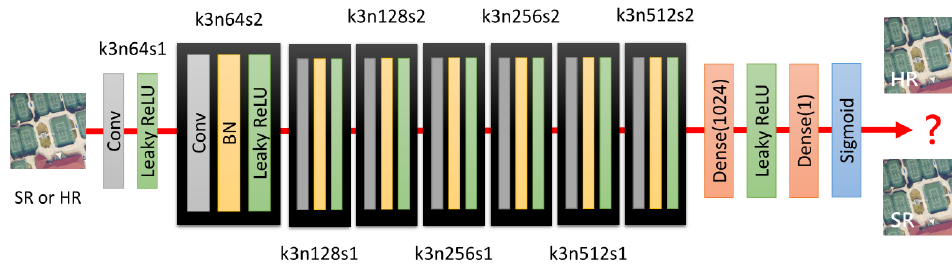
Figure 6. Network architecture of the